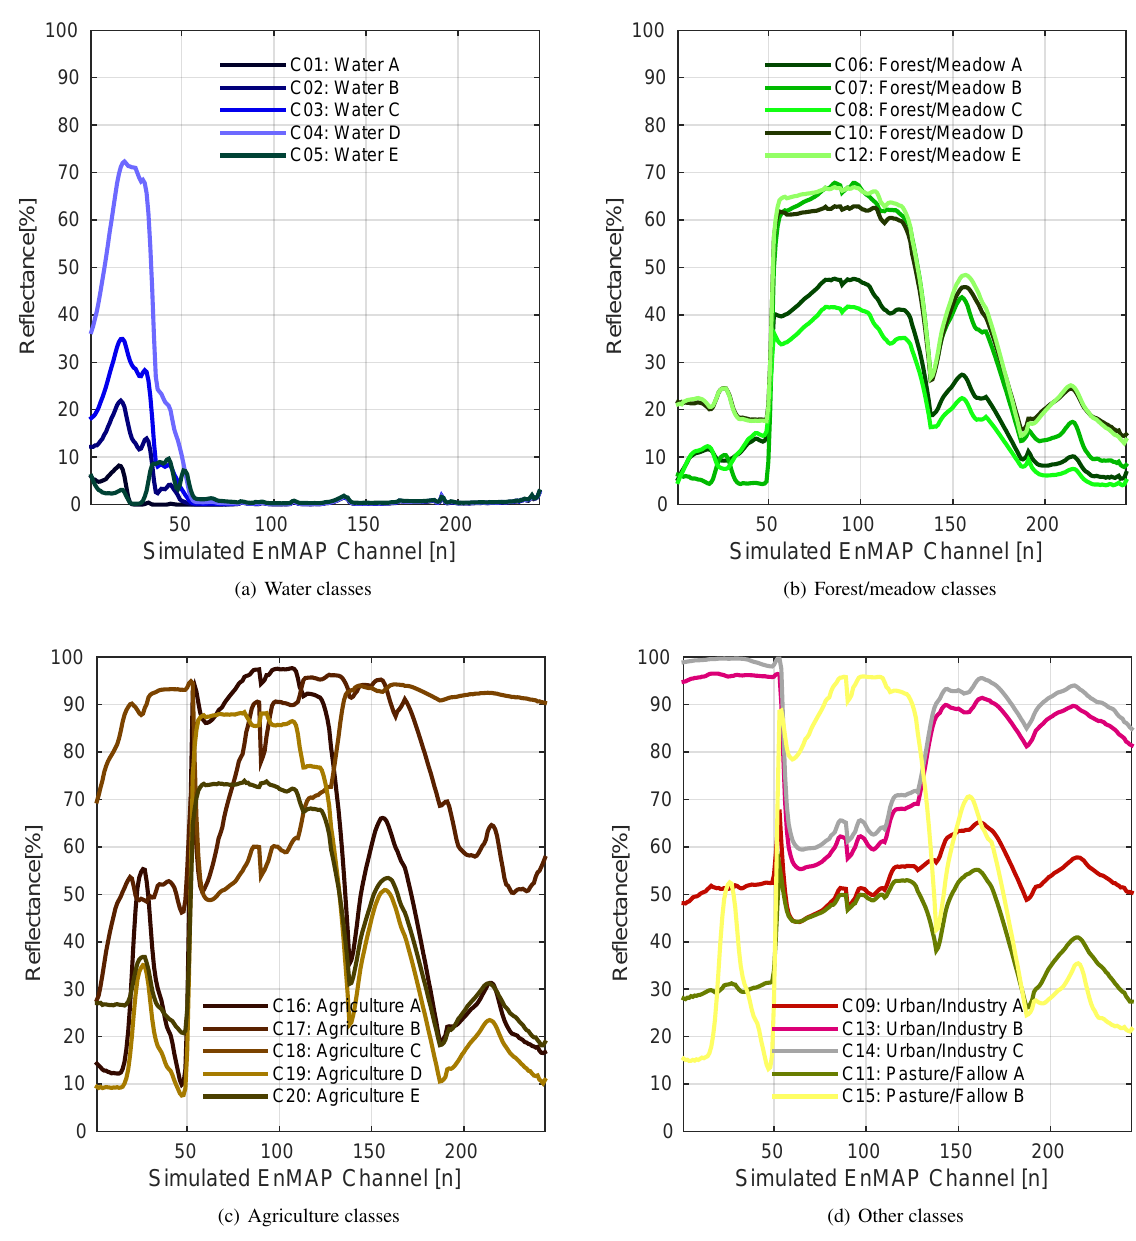
Figure 3. Average spectra for the 20 land use classes of the EnMAP contest dataset: (a) water classes, (b) forest/meadow classes, (c) agriculture classes, (d) other